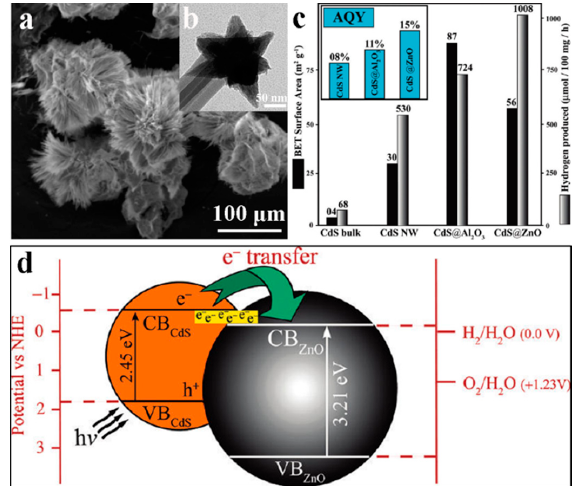
Figure 11. ( a , b ) SEM and TEM morphology of CdS@ZnO nano-urchins; ( c ) BET surface area plot and amounts of H 2 generated from different samples. (Inset) Percentage of apparent quantum yields for different samples; ( d ) schematic illustration for electron transfer in the CdS@ZnO nano-urchin (Reproduced with permission from [143], Copyright 2012, American Chemical